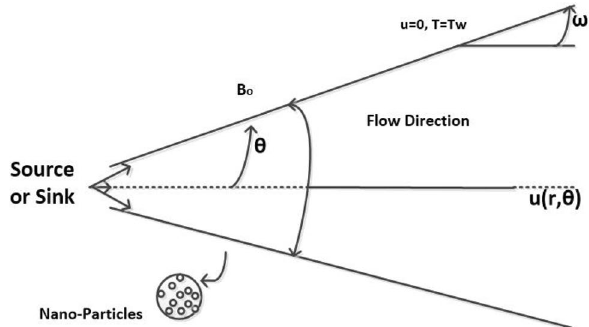
Figure 1. Geometry of the